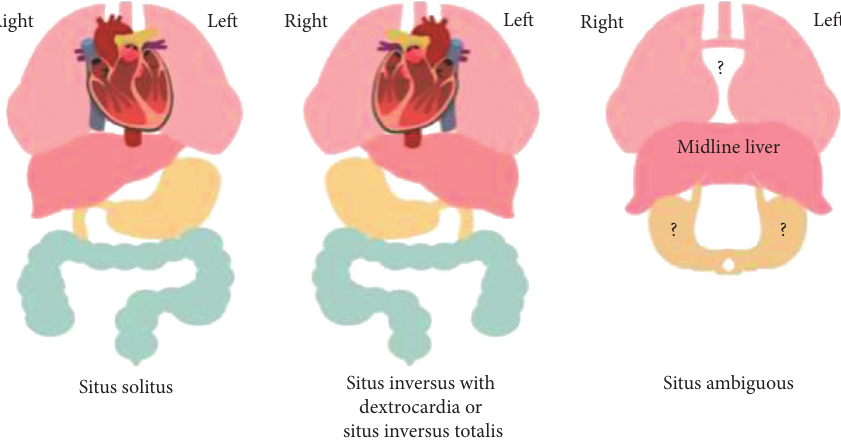
Figure 2: Illustration of situs solitus, situs inversus totalis, and situs ambiguous.